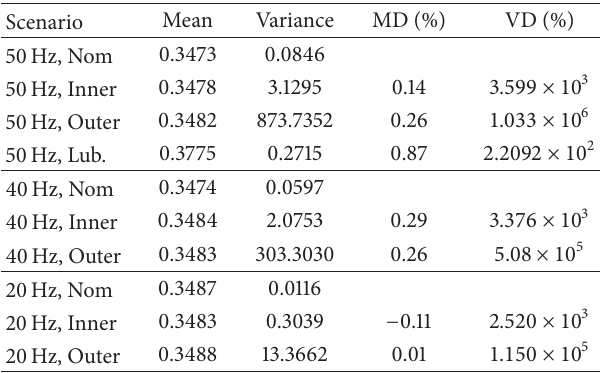
Table 1: Statistical evaluation of vibration